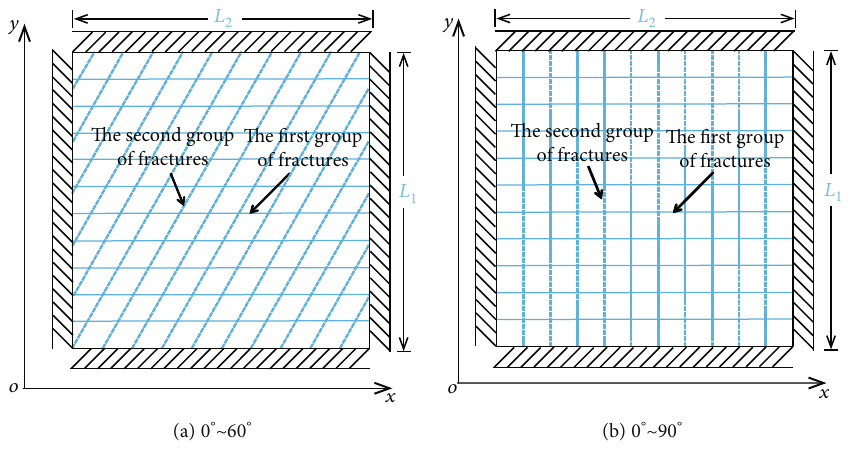
Figure 21: Schematic diagram for two groups of fracture models.